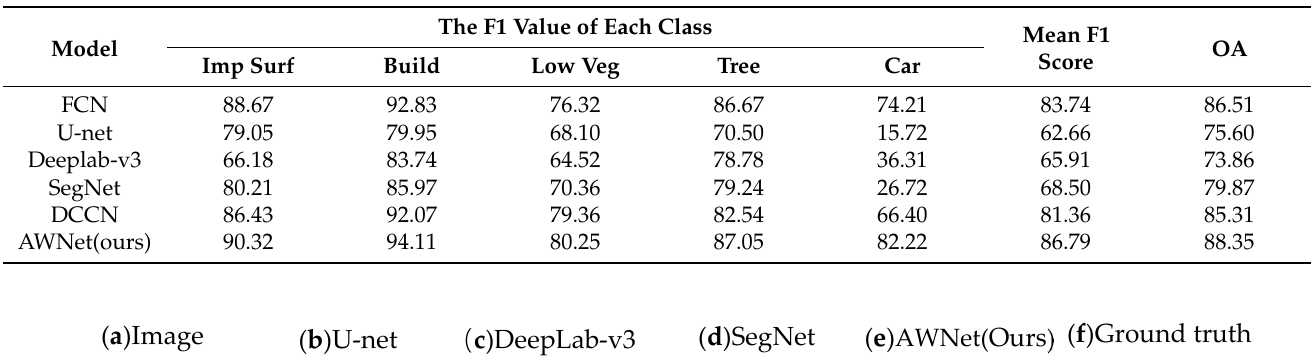
Table 3. The results of comparing our network with the landmark classic network.